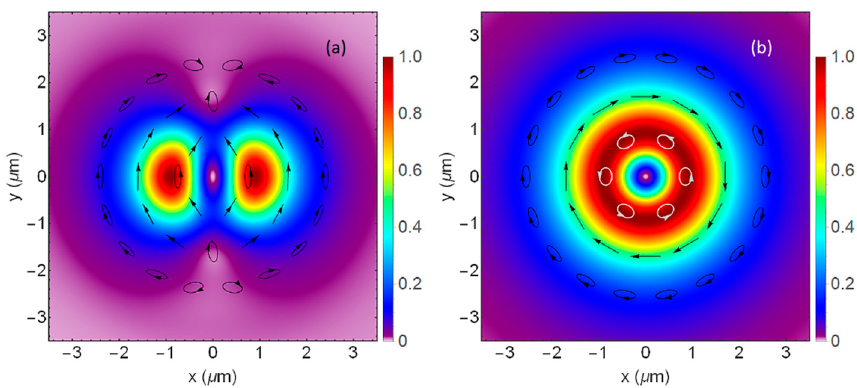
Figure 5. Focal spot generated by variation 1B ( a ); focal spot generated by variation 1C ( b ).